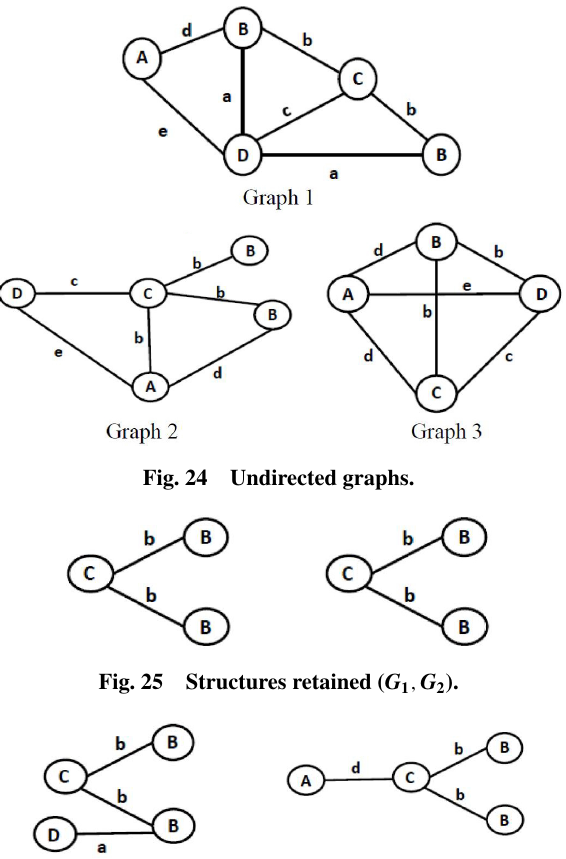
Fig. 26 Pruned subgraphs ( G 1 ; G 2